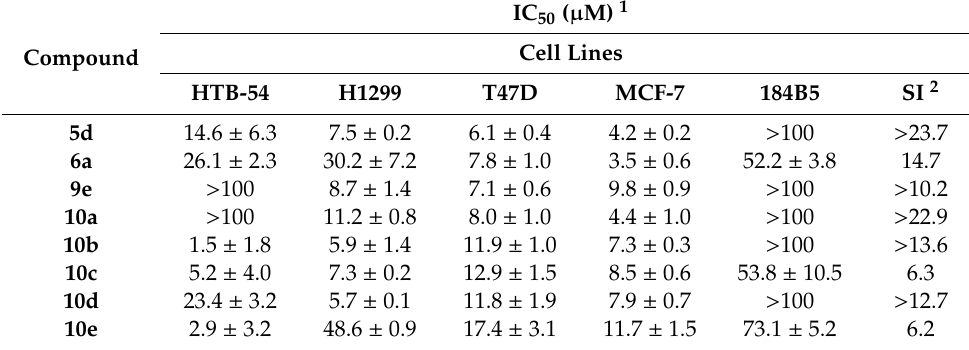
Table 1. Cytotoxic activity, expressed as average IC 50 values ( µ M) and selectivity indexes (SI) calculated of derivatives 5d , 6a , 9e , 10a , 10b , 10c , 10d , and 10e